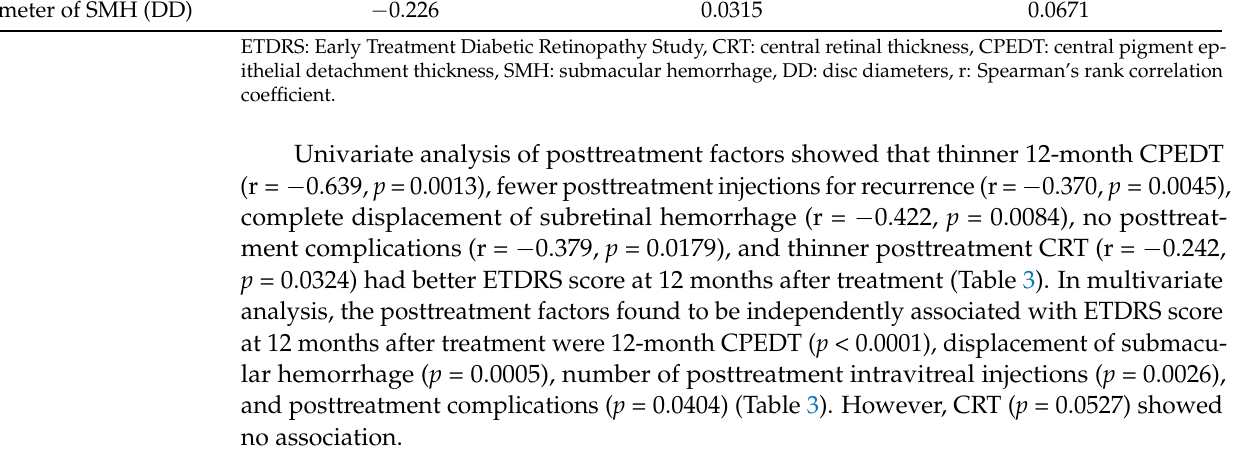
Table 3. Analysis of Posttreatment Factors Associated with 12-Month Posttreatment ETDRS